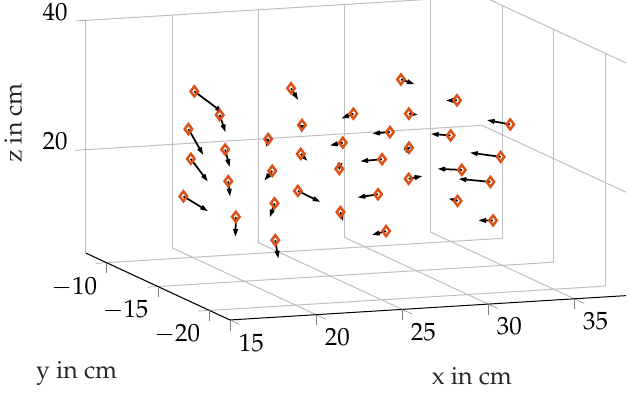
Figure 18. Calibration map points and the displacement arrows.